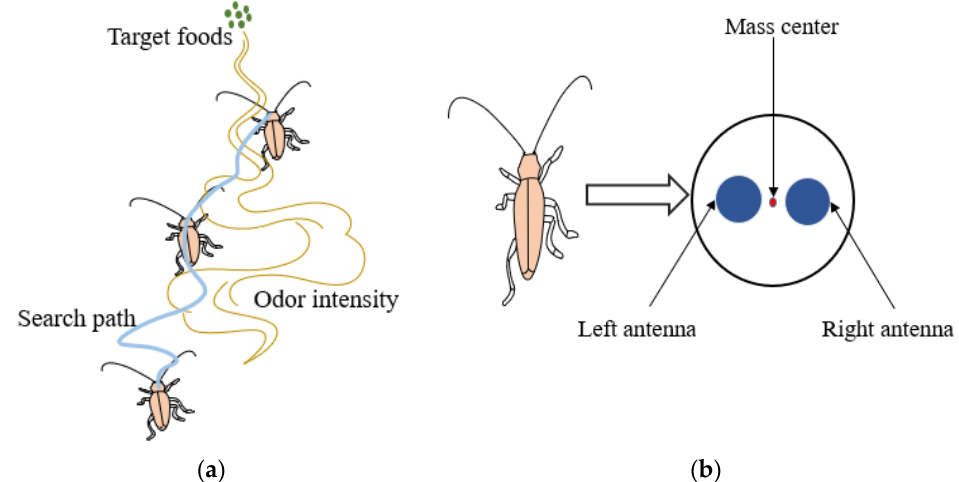
Figure 5. ( a ) Foraging behavior of the long-antenna beetle. ( b ) Simplified model of beetle.